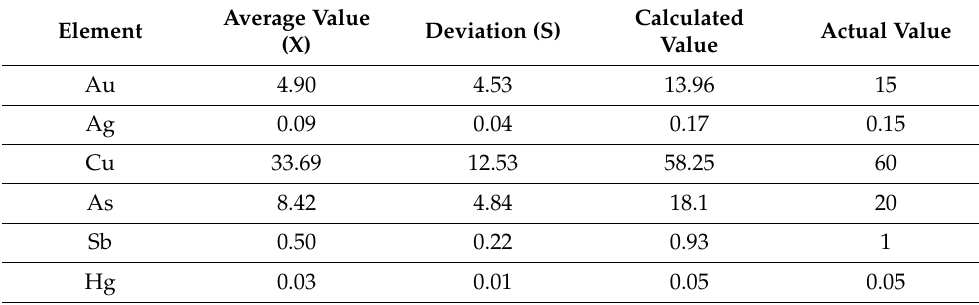
Table 2. The lower limit of the soil geochemical investigation in the Nanpo gold deposit.